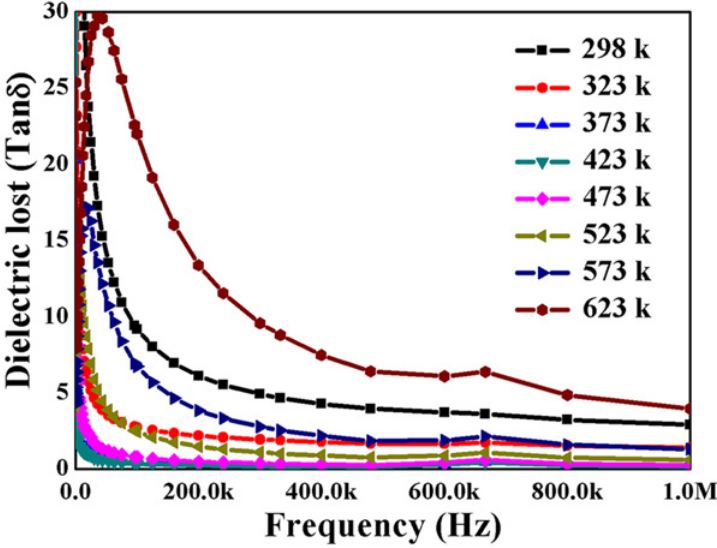
Fig 7. The dielectric loss CeO 2 nanoparticles versus frequency of applied field at various temperatures.